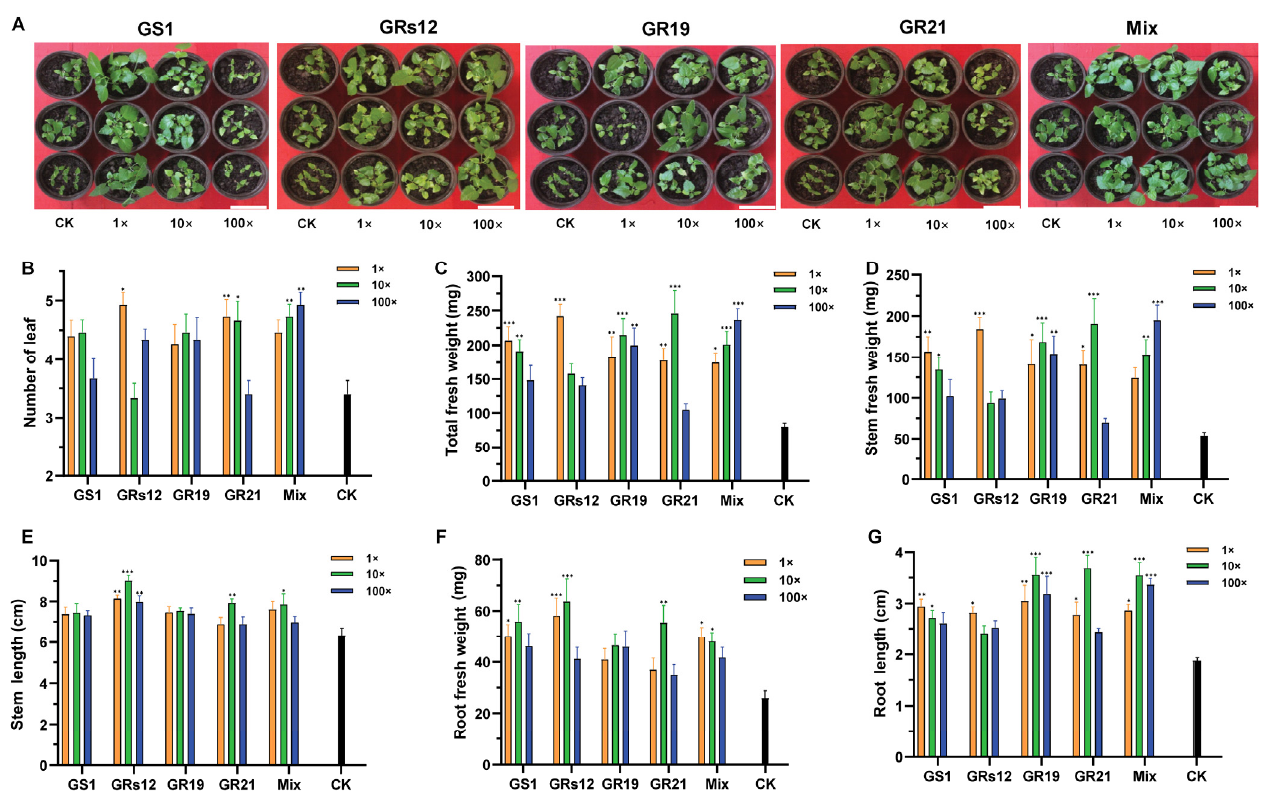
Figure 3. The growth-promoting effects of PGPF on mulberry seedlings. ( A ) The representative photograph of mulberry seedlings after 42 days inoculated with fungal suspensions. The bar represented 10 cm. ( B ) Number of mulberry leaves. ( C ) Total fresh weight of mulberry. ( D ) Fresh weight of mulberry stems. ( E ) Length of mulberry stems. ( F ) Fresh weight of mulberry roots. ( G ) Length of mulberry roots. 1 × , Mulberry treated with the initial concentration of fungal suspensions; 10 × , Mulberry treated with the 10-fold dilution of fungal suspensions; 100 × , Mulberry treated with the 100-fold dilution of fungal suspensions. GS1, GRs12, GR19, GR21, Mix, and CK represented mulberry seedlings treated with Talaromyces sp. GS1, Pseudeurotium sp. GRs12, Penicillium sp. GR19, Trichoderma sp. GR21, mixed fungal suspension, and water, respectively. The black bars represented mulberry groups treated with water. Values represented the mean ± standard deviation of replicates ( n = 15). Statistically significant differences between fungi-treated and control groups were analyzed using Dunnett’s one-way analysis of variance. *** p < 0.001, ** p < 0.01, * p < 0.05.